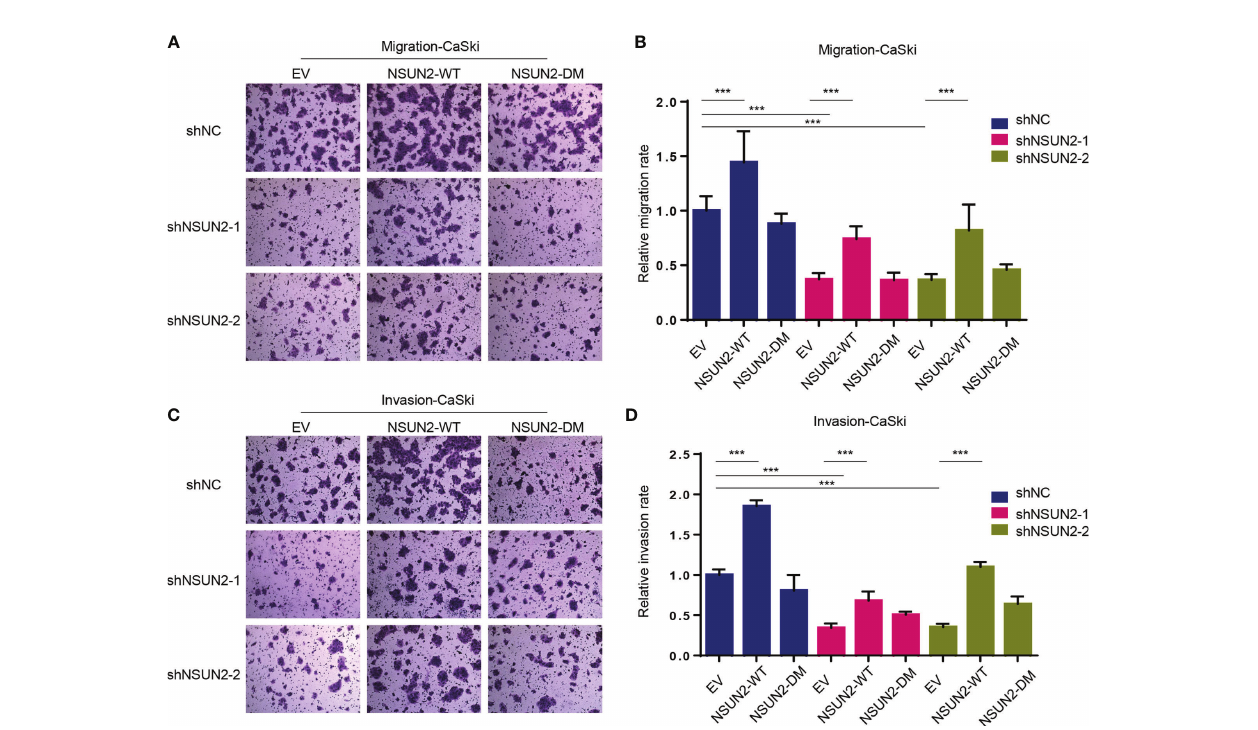
FIGURE 3 | NSUN2 promotes migration andinvasion of cervicalcancer cells in an m 5 C-dependent manner. (A,B) Effect of wild-type or mutant NSUN2 on cellmigration in NSUN2 knockdownCaSki cells. Representative images (A) and quanti fi cation (B) of transwellassaysshowedthe migration capability of CaSki cells. (C,D) Effect of wild-type or mutant NSUN2 oncellinvasion in NSUN2 knockdownCaSkicells. Representative images (C) and quanti fi cation (D) of transwellassaysshowedthe invasion capability of CaSki cells. (EV, empty vector;data shownare mean ± SEM, n = 3, Student ’ s unpaired t -test was used for statistical analysis, *** p <